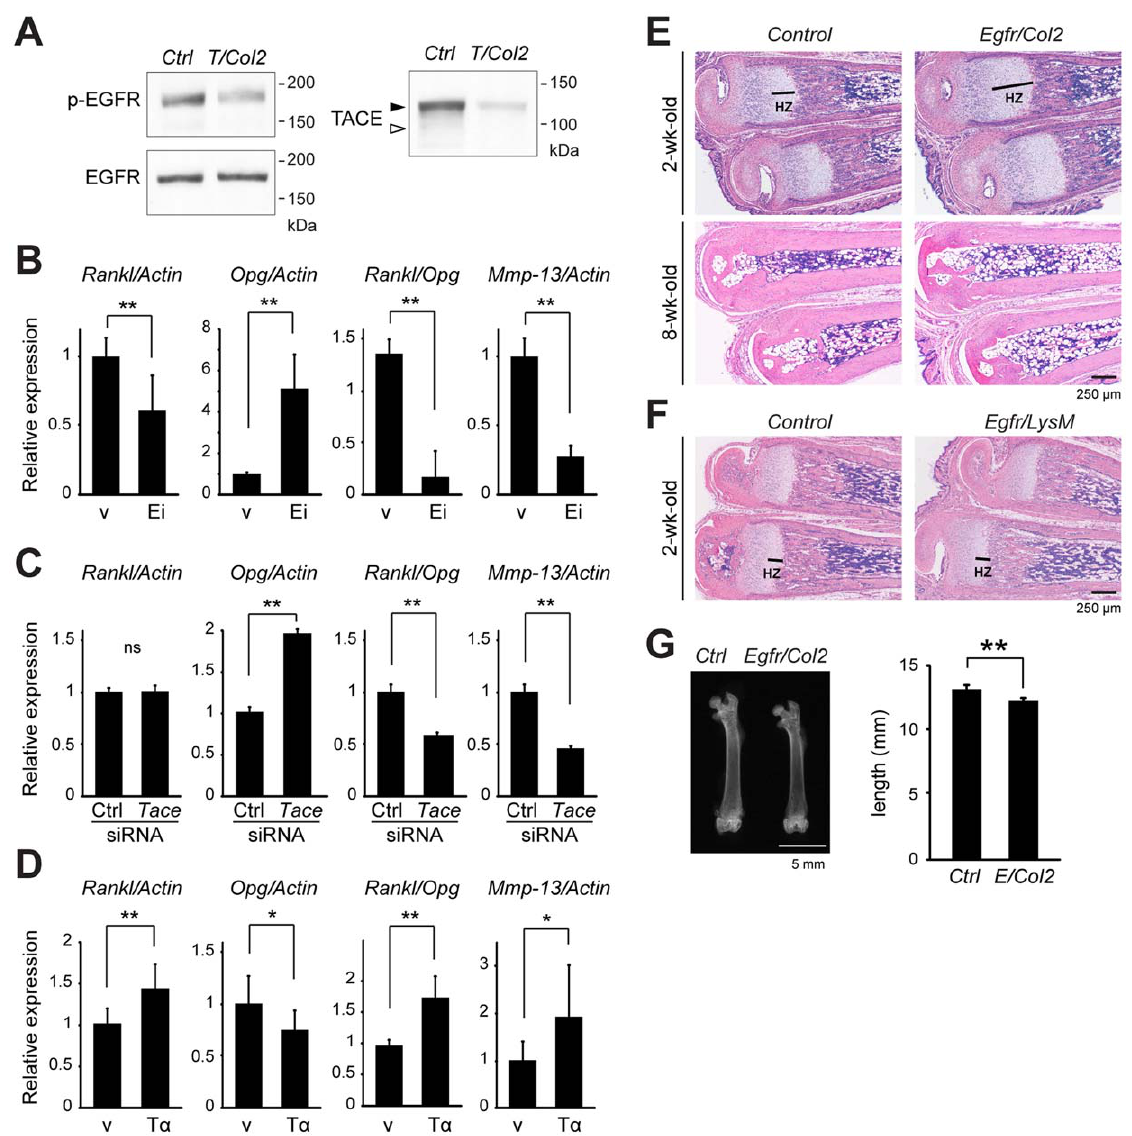
Figure 4. The conditional ablation of EGFR in chondrocytes leads to elongated growth plate and shorter long bones. (A) Western blot analysis of phospho-EGFR, EGFR, and TACE in the cartilage tissues collected from Control and Tace/Col2 mice. (B–D) Primary chondrocytes collected from wild-type newborn mice were incubated with vehicle (v), EGFR inhibitor (Ei), or TGF a (T a , 50 ng/ml) (B and D), or treated with control (Ctrl) or Tace -siRNA (C). The levels of the Rankl , Opg , Mmp-13 , and b -Actin transcripts were analyzed by quantitative RT-PCR. The results are expressed as the mean 6 SD of at three independent experiments. (E and F) Sections of the metatarsi from Egfr flox/flox /Col2-cre ( Egfr/Col2 ), Egfr flox/flox /LysM-cre ( Egfr/ LysM ), and Control mice. HZ, hypertrophic zone. (G) X-ray analysis of the femur of 8-week-old Control ( Ctrl ) and Egfr flox/flox /Col2-cre mice ( Egfr/Col2 ). The results are expressed as the mean 6 SD of at least three mice in each group. *, p , 0.05. **, p , 0.005.